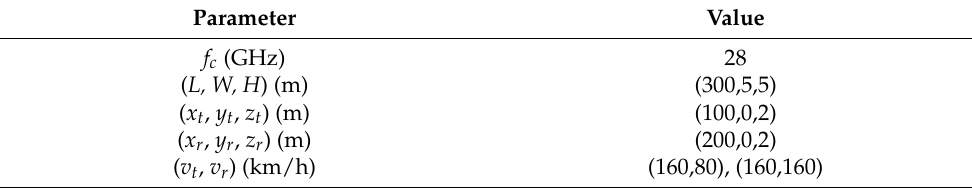
Figure 5. Schematic diagram of WI simulation tunnel. Table 1. Parametric structure of transmitted and receiving antennas in Table 1. Parametric structure of transmitted and receiving antennas in tunnel.